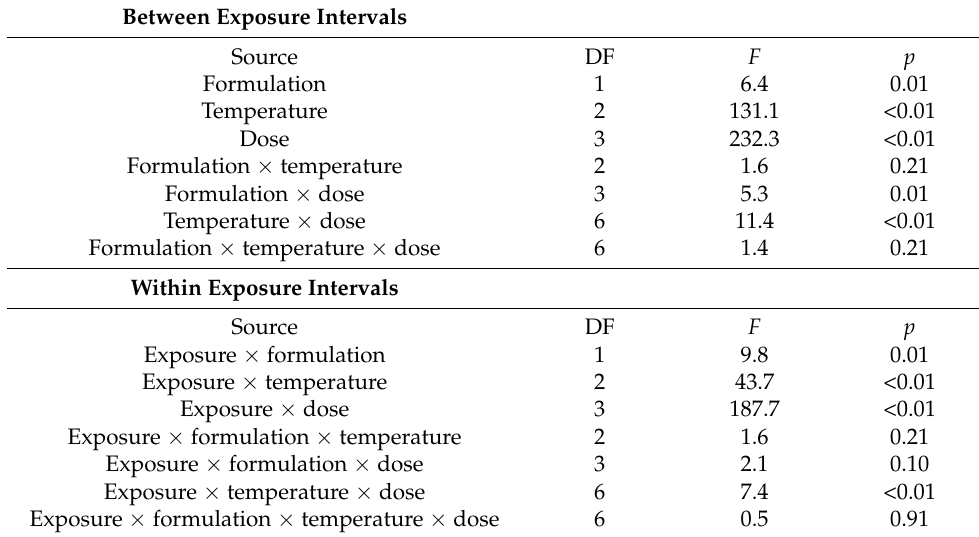
Table 1. Multivariate Analysis of Variance (MANOVA) parameters for main effects and associated in- teractions for mortality levels of Prostephanus truncatus adults between and within exposure intervals (total degrees of freedom, DF = 192).